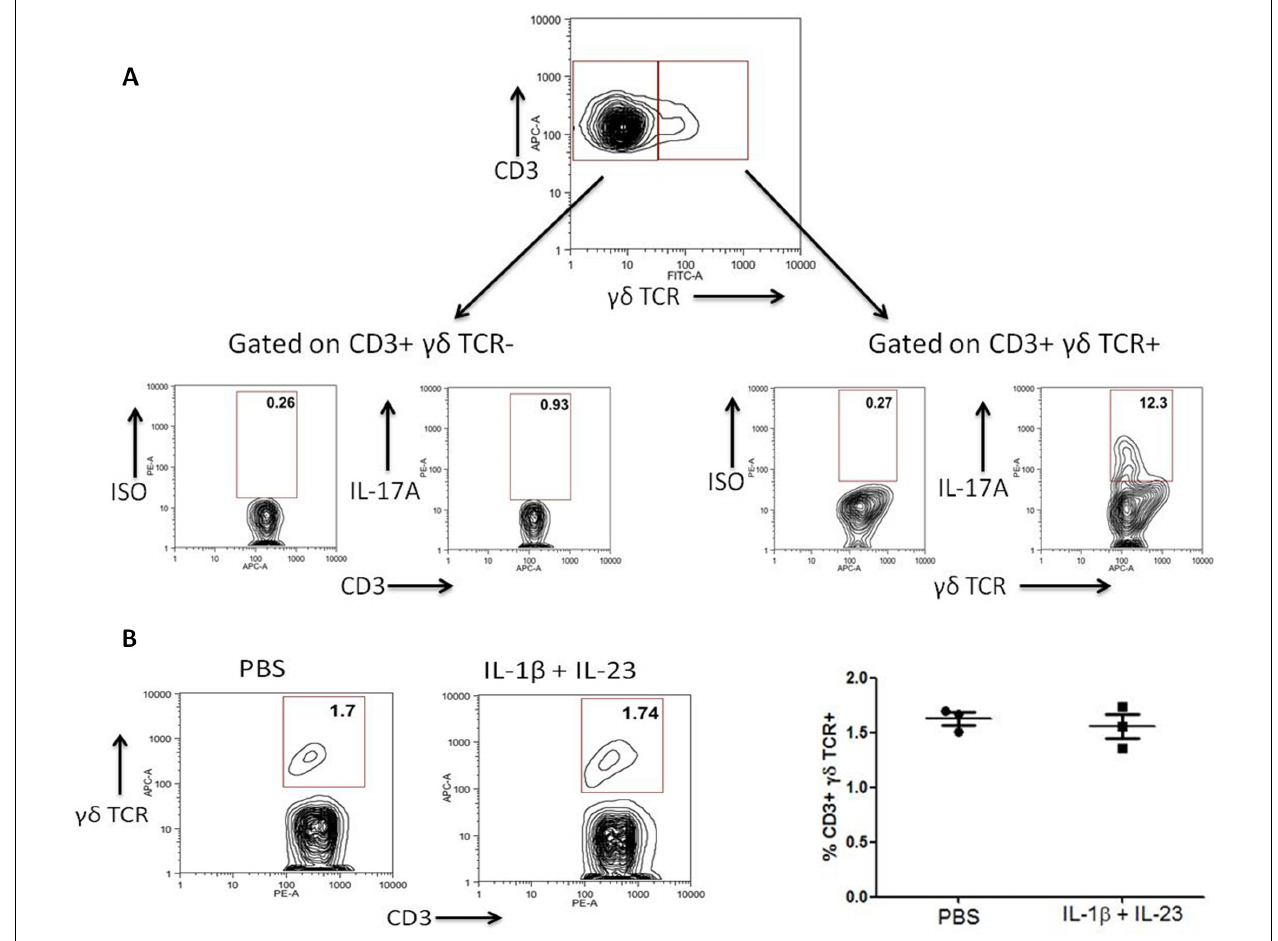
FIGURE 1 | IL-1 β and IL-23 induce rapid expression of IL-17A by γδ T cells in vivo . C57Bl/6 mice were injected into the hind footpad with IL-1 β (50 ng) and IL-23 (50 ng) or PBS. After 4 h cells were harvested from the popliteal lymph nodes and treated for a further 4 h with brefeldin A without ex vivo stimulation. Cells were stained for expression of CD3, γδ TCR and intracellular